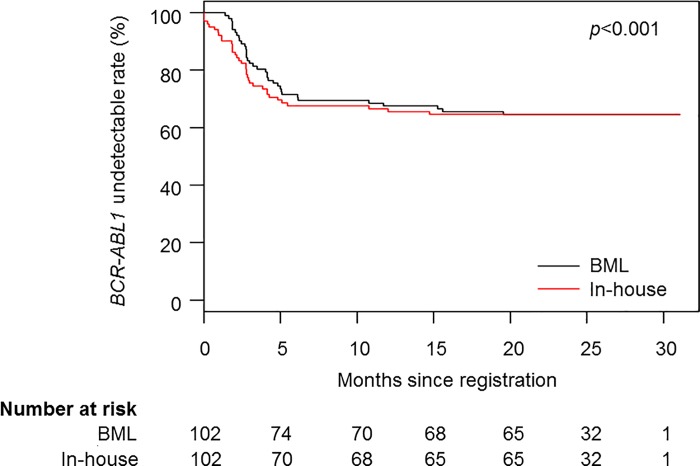
Kaplan-Meier curves of BCR-ABL1 undetectable rate comparing with the BML method and in-house method.